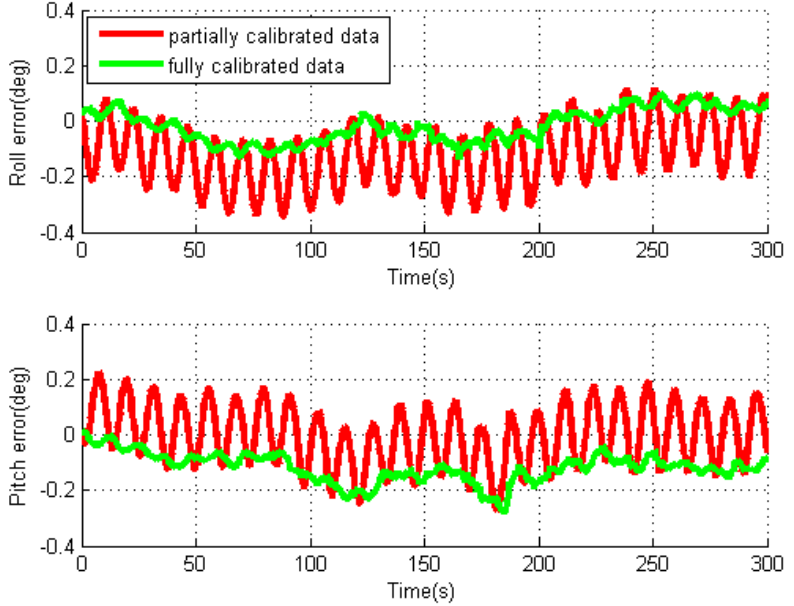
Figure 10. Roll and pitch errors for rotary INS with NAV440.